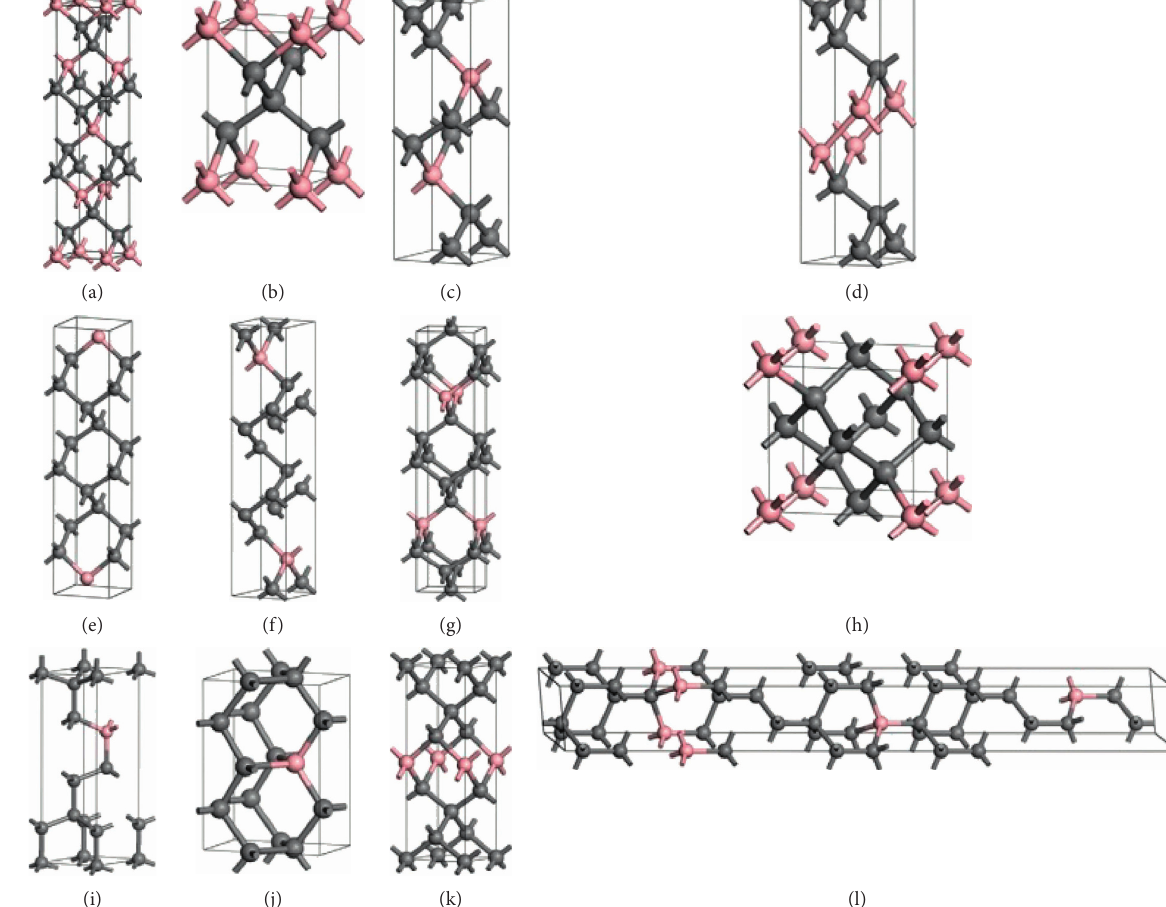
Figure 1: Crystal structures of (a) BC